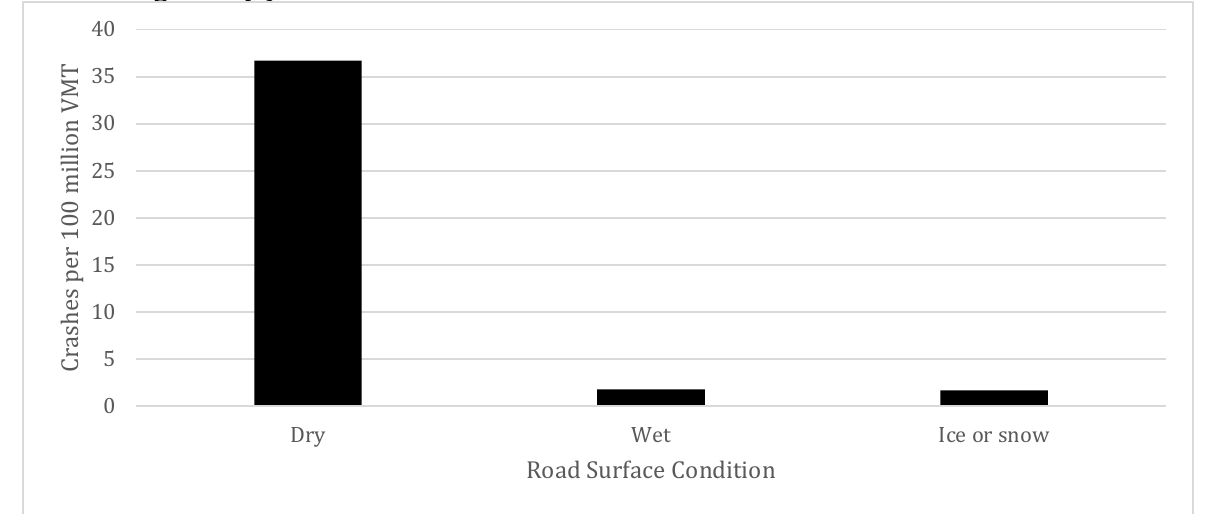
Figure 4 (a): Rate of animal-vehicle crashes based on road surface